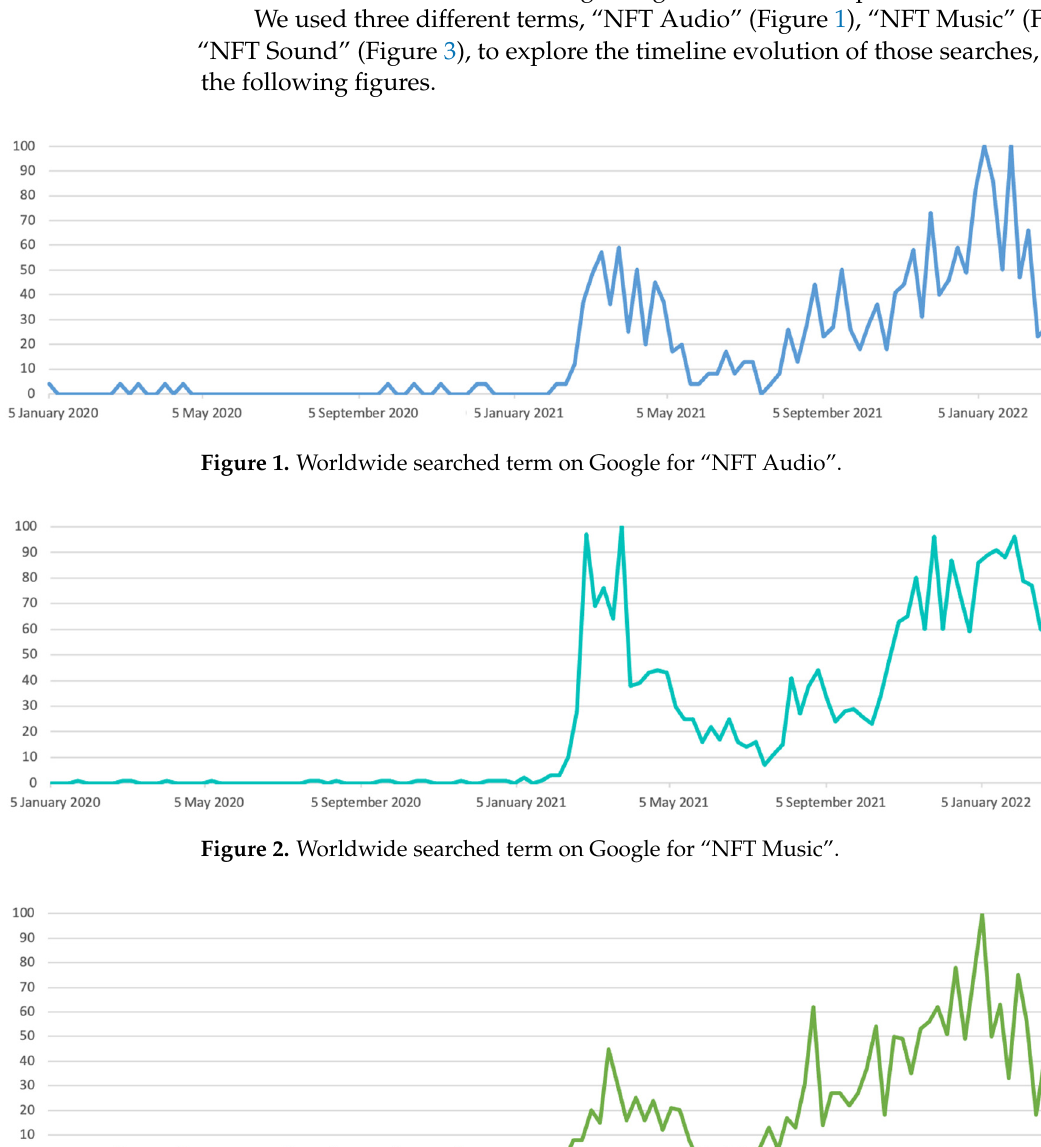
Figure 1. Worldwide searched term on Google for “NFT Audio”.